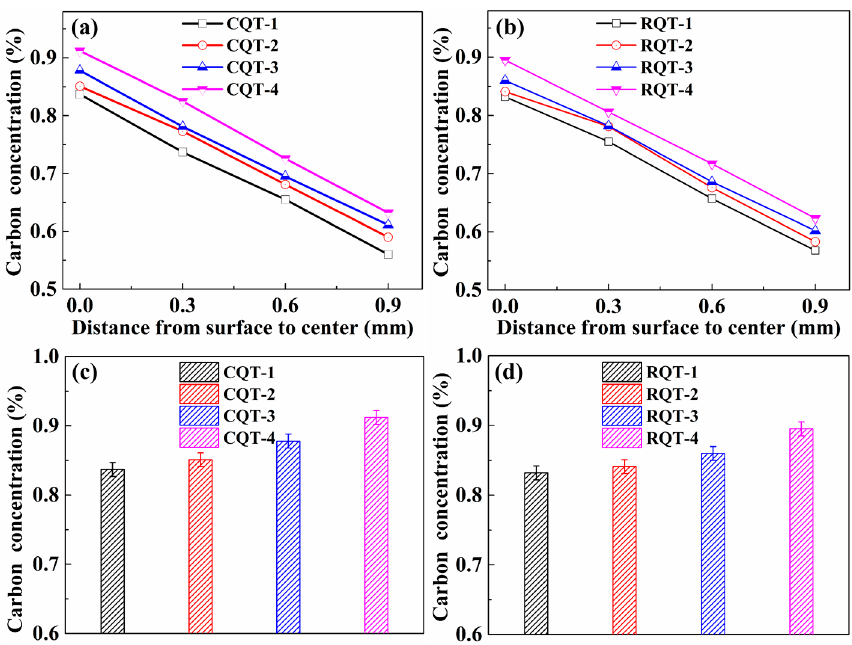
Figure 5. Carbon gradient after CQT ( a ) and RQT ( b ) processes, and the surface carbon concentration of the specimens after CQT ( c ) and RQT ( d ) processes.